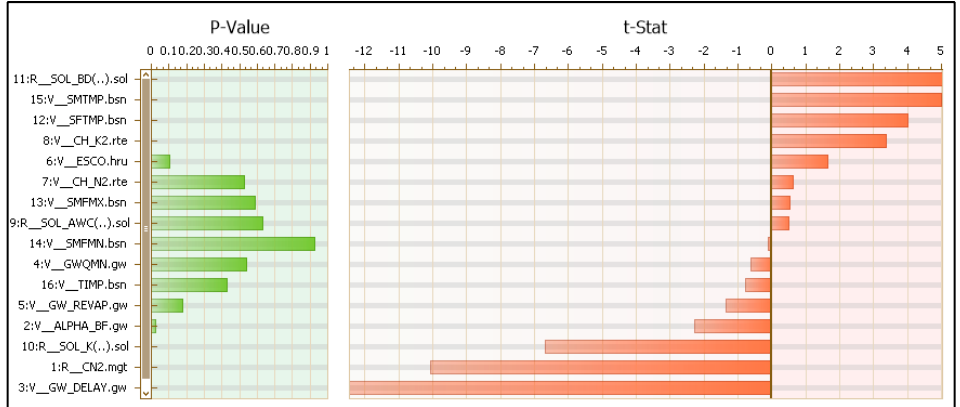
Figure 7. Results of Global Sensitivity Analysis for Haro River watershed.